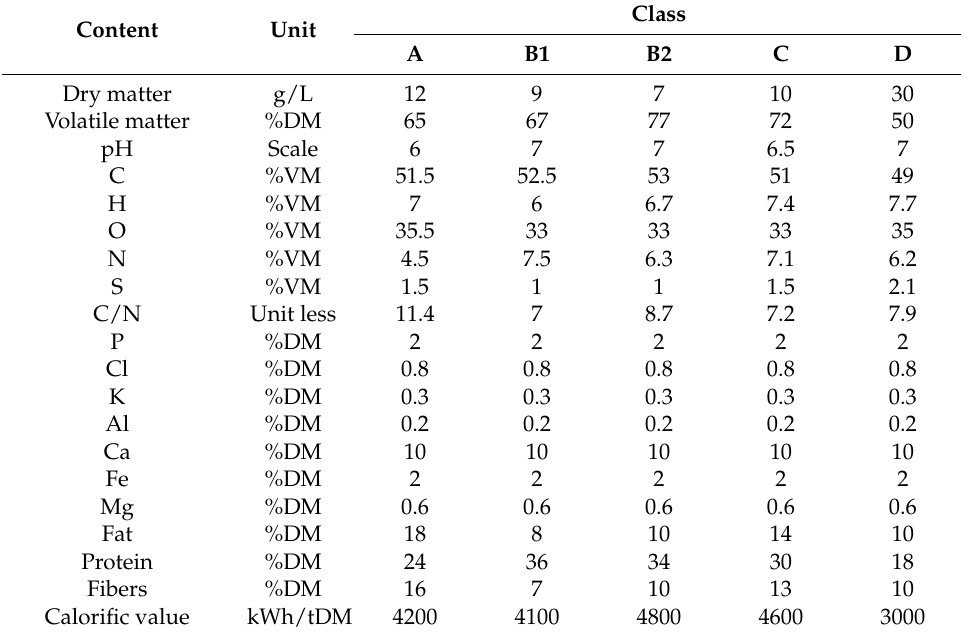
Table 1. The composition of wastewater sludge with respect to the treatment applied to it. Content